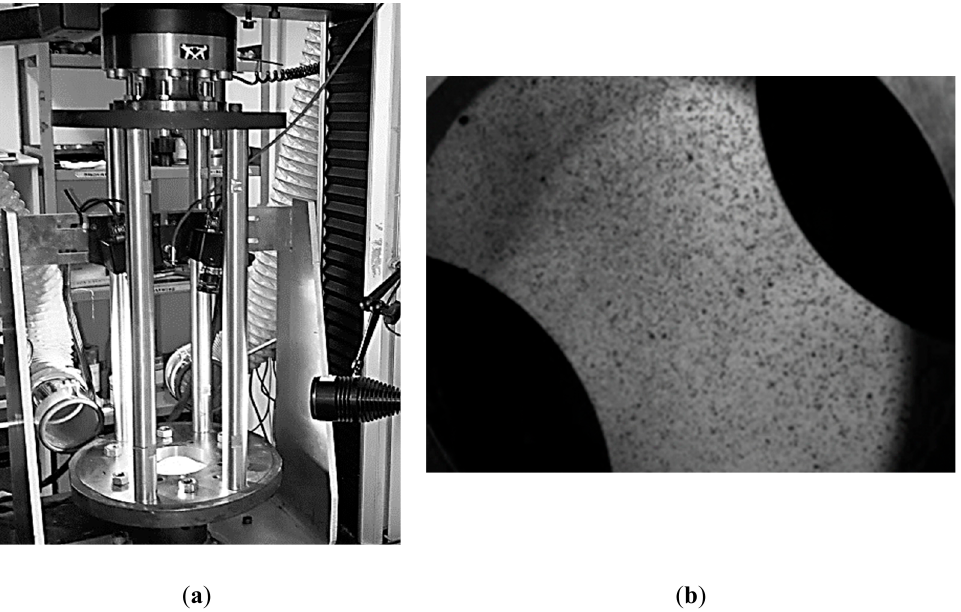
Figure 4. Formability tests: ( a ) the adopted equipment; ( b ) stochastic pattern for the Digital Image Correlation (DIC) analyses.